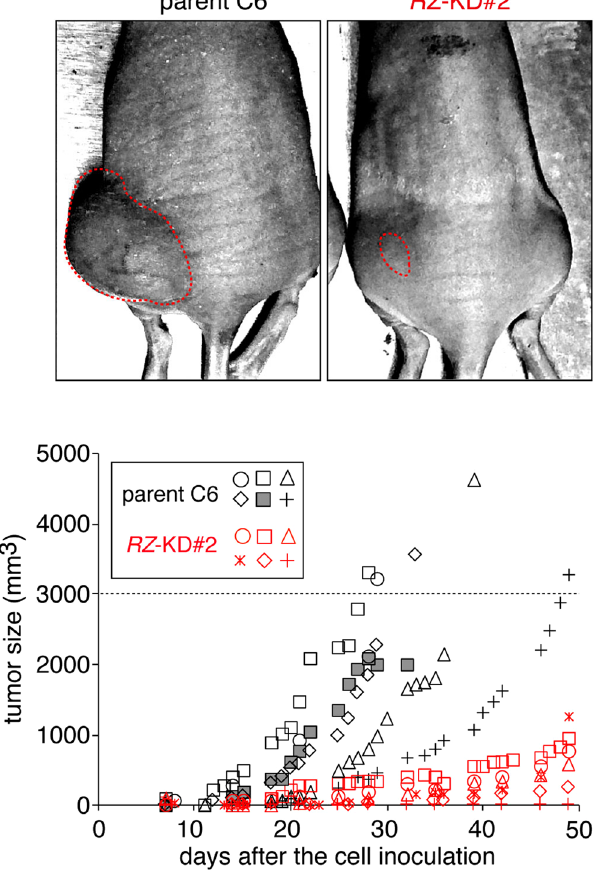
Figure 3. Decreased tumor growth in the Ptprz -knockdown glioblastoma cell xenografts. Subcutaneous xenograft tumor model. Nude mice were implanted subcutaneously with parental and RZ -KD#2 cells (5 × 10 6 cells). The results were obtained from five independent cell preparations for the C6 group and two independent cell preparations for the RZ -KD#2 cell group. Images are representative of six animals per group 30 days after the cell injection, in which the tumor rims were surrounded by red dotted lines. Tumor size was measured until it reached the humane endpoint for sacrifice ( > 3,000 mm 3 or 50 days after the cell injection): the C6 group reached the predetermined humane endpoint at 30 days after cell injections. The plot shows tumor growth for each animal. One mouse (a gray square symbol) was sacrificed because of tumor necrosis and bleeding at 34 days. The days required to reach a tumor volume of 3,000 mm 3 were significantly different between the parental C6 and RZ -KD#2 groups ( P < 0.01; Mann-Whitney U -test). The average tumor sizes at 30 days were significantly different between the two groups ( P < 0.01, Student’s t